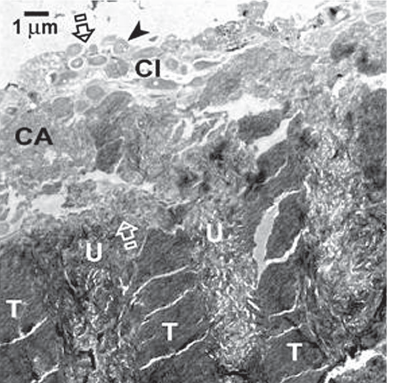
FIGURE 4 -TEM of the interface of ABF bonded to caries-affected dentin. Although the hybrid layer (H) was about 3 µ m thick, the underlying undemineralized dentin (U) was highly porous (arrow head). The dentinal tubule was covered with a smear plug(SP), and was partially filled with large caries crystals (arrows).